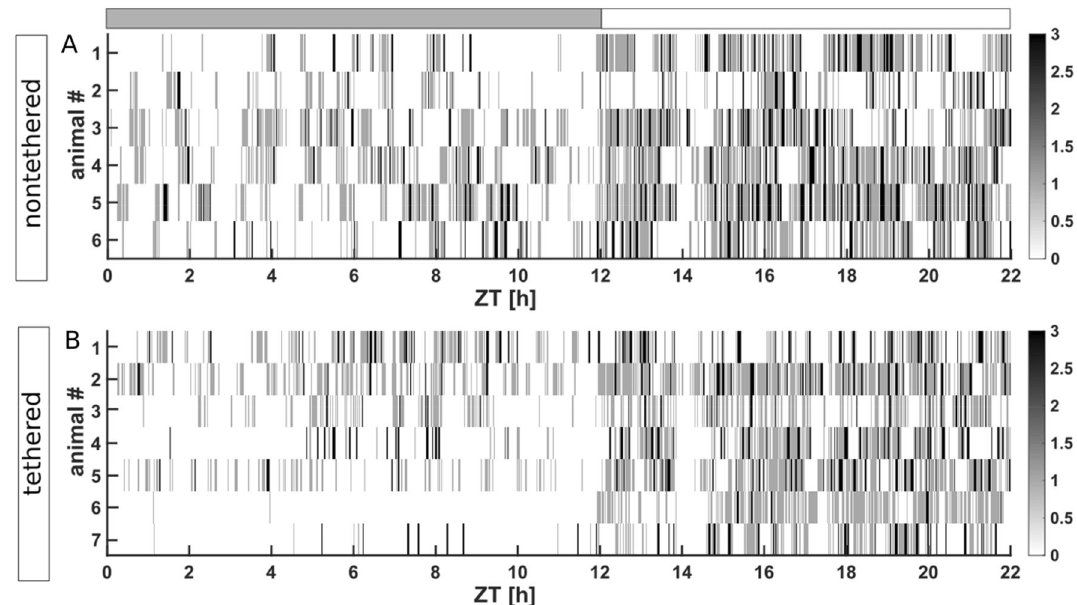
Figure 2. Hypnogram of the nontethered ( A ) and tethered ( B ) animals throughout the 22 h experimental observation period. Lights were turned on after 12 h. The x-axis represents Zeitgeber time (ZT). The gray rectangle exhibits the dark phase, the white rectangle exhibits the light phase. White exhibits WAKE, light gray exhibits NREM sleep and dark gray exhibits REM sleep. The synchronous interruption of sleep at H14 (ZT) coincides with entering the animal room to take nest photos. This synchronous interruption at this time of the day is visible throughout the entire experimental observation period. #: individual animal